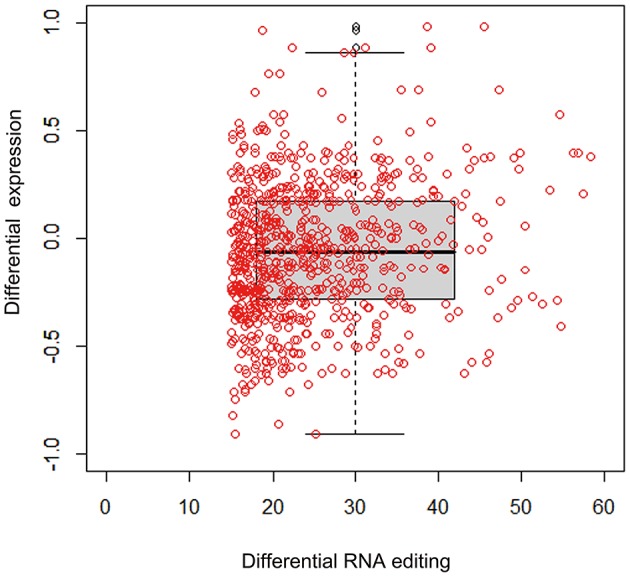
Relationship between editing level and expression change. Correlation between editing level and mRNA level changes of associated genes between gentamycin treated and control groups (Pearson's correlation test: r = 0.10, 95% CI: 0.06–0.20, p = 0.0088). Each red dot stood for an editing site with a cutoff of 15% editing level change.